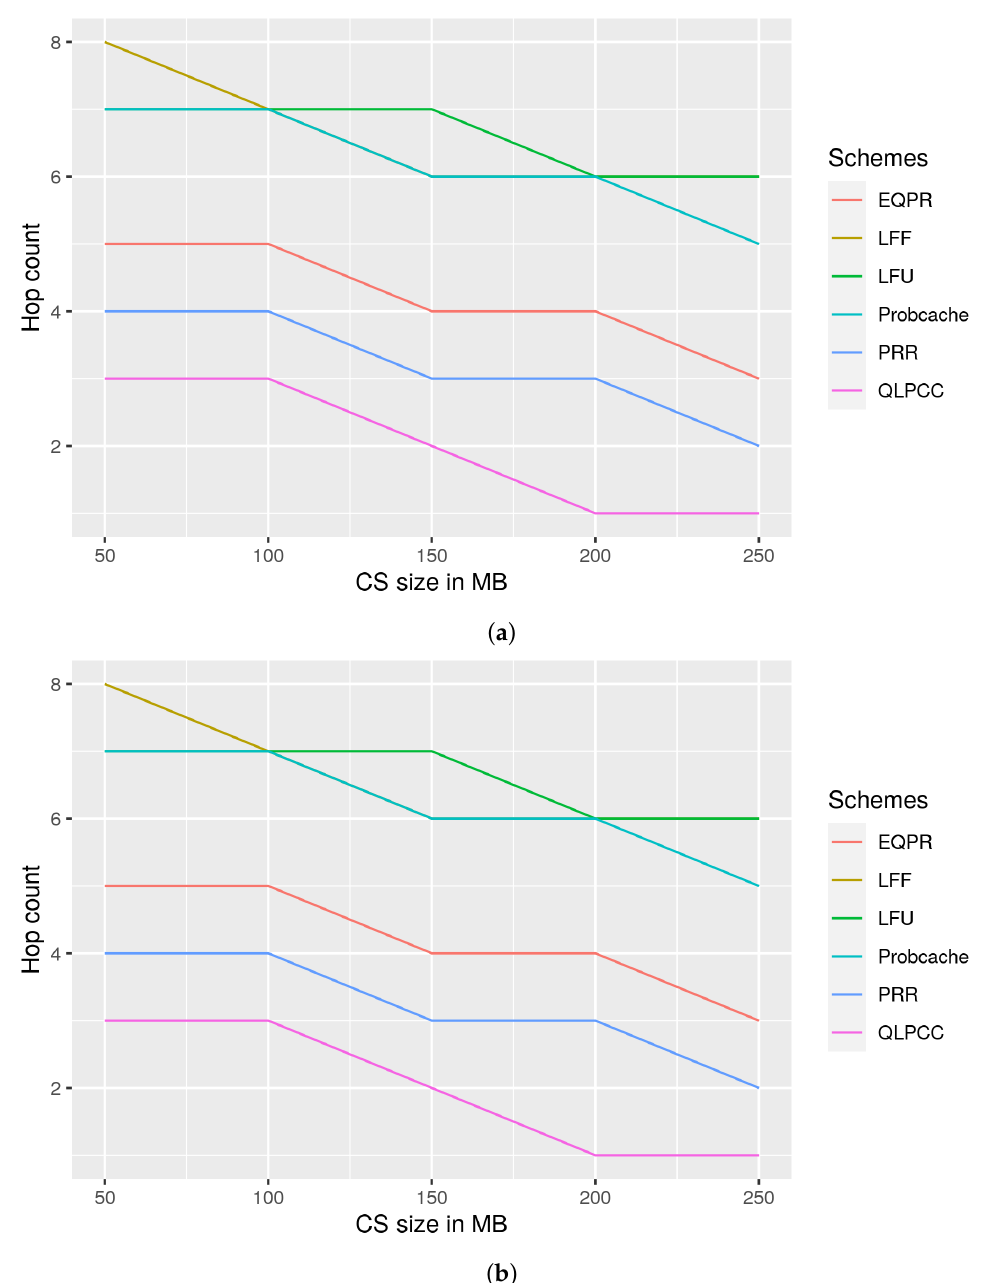
Figure 10. Hop count vs. content store size for overall traffic. ( a ) Hop count vs. content store size (overall traffic) for | M | = 500. ( b ) Hop count vs. content store size (overall traffic) for | M | =